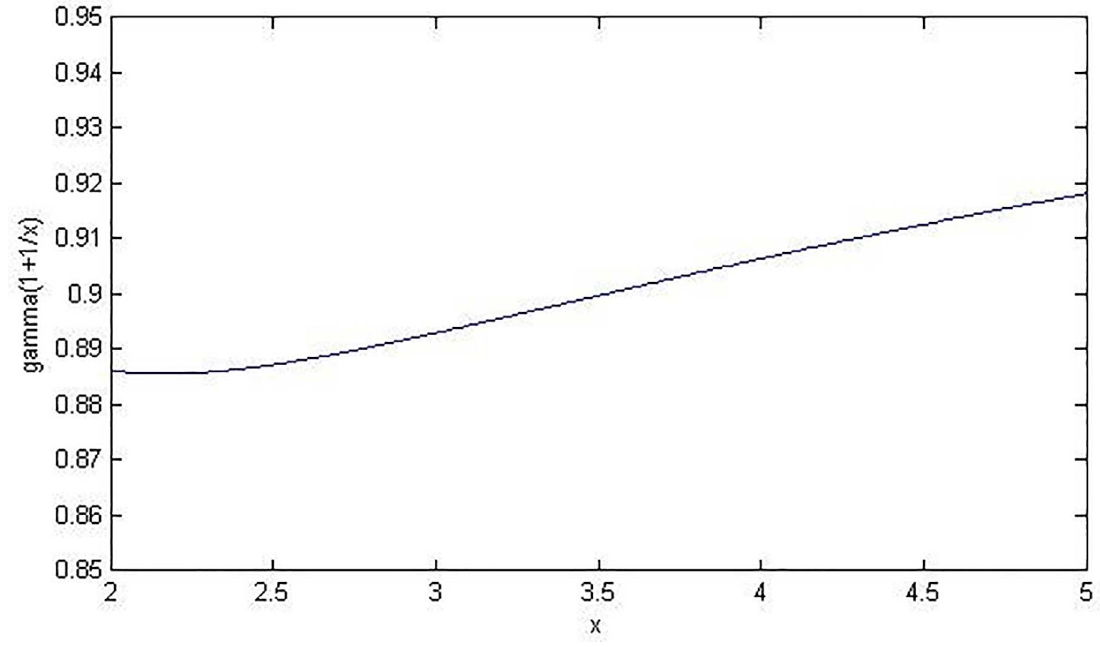
(cid:0) (cid:1) against X on the interval of (2, 5). X